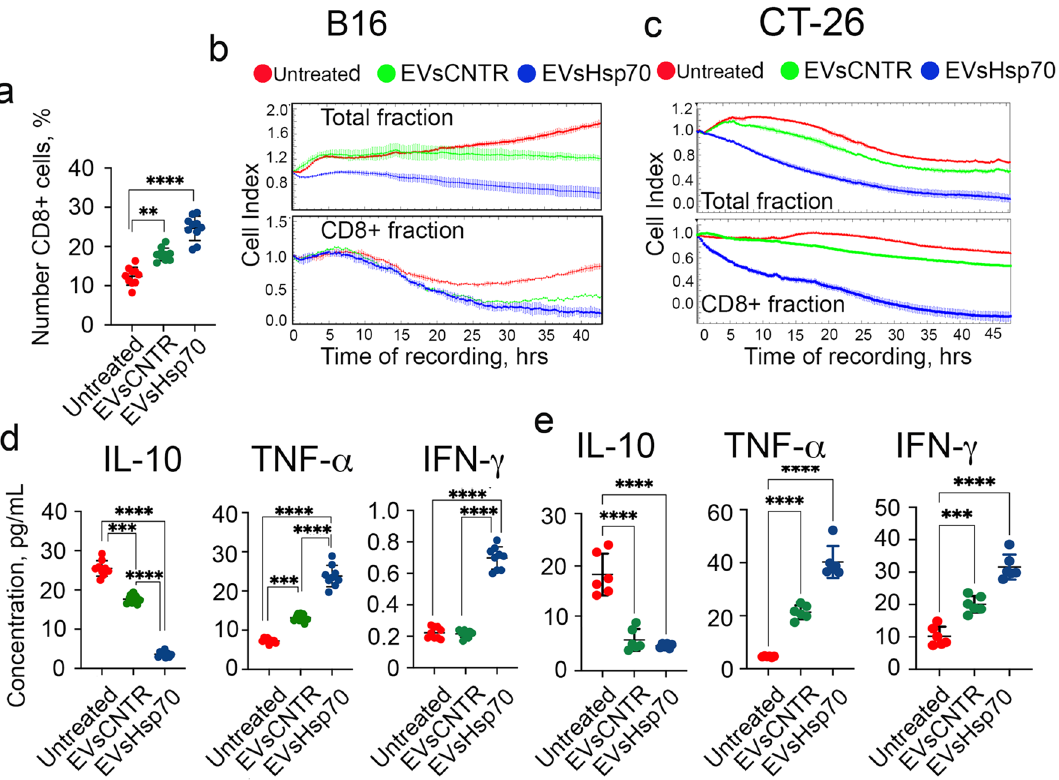
Figure 5. Hsp70-containing EVs cause the generation of a specific immune response. ( a ) Lymphocytes from B16 tumor-bearing mice were isolated from spleens, magnetically separated and the CD8 + cells were counted (** p < 0.0001, Dunnett’s multiple comparison test). ( b , c ) Lymphocytes from B16 tumor-bearing mice from three groups ( b ) and from CT-26-bearing mice ( c ) were used as effector cells in the CTL assay performed with the aid of xCELLigence (total fraction, upper panel) and from the CD8 + lymphocyte fraction (lower panel). ( d , e ) The concentration of three cytokines (IL-10, TNF-α and IFN-γ) were measured in sera of B16-bearing mice ( d ) and CT-26-bearing mice ( e ) on day 19 after tumor cell inoculation. ( *p = 0.0003; **p < 0.0001, Dunnett’s multiple comparison